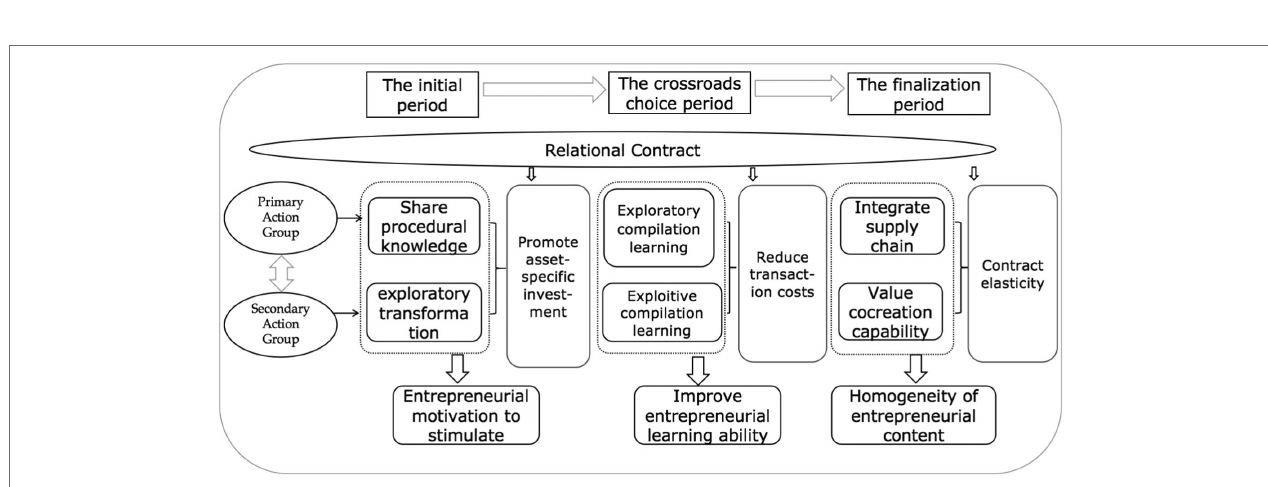
FIGURE 2 | Relational contracts act on the whole process of clan member entrepreneurship.